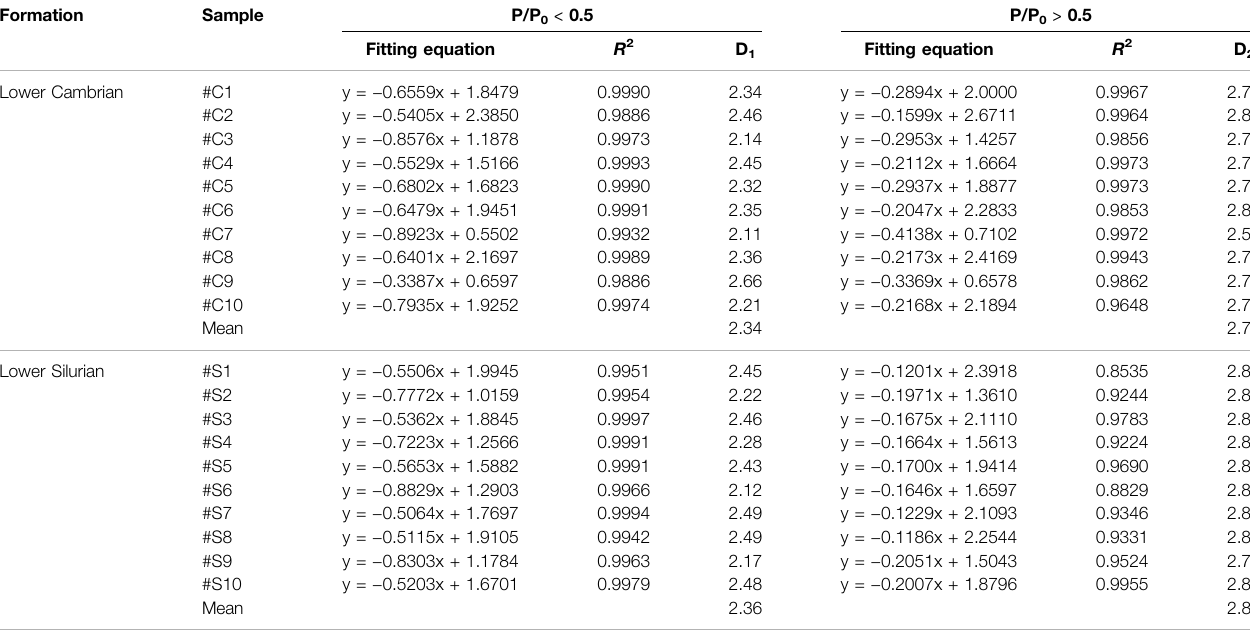
TABLE 3 | Fractal dimensions calculated by the fractal Frenkel – Halsey – Hill (FHH) model and derived from N 2 adsorption isotherms. Formation Sample P/P 0 < 0.5